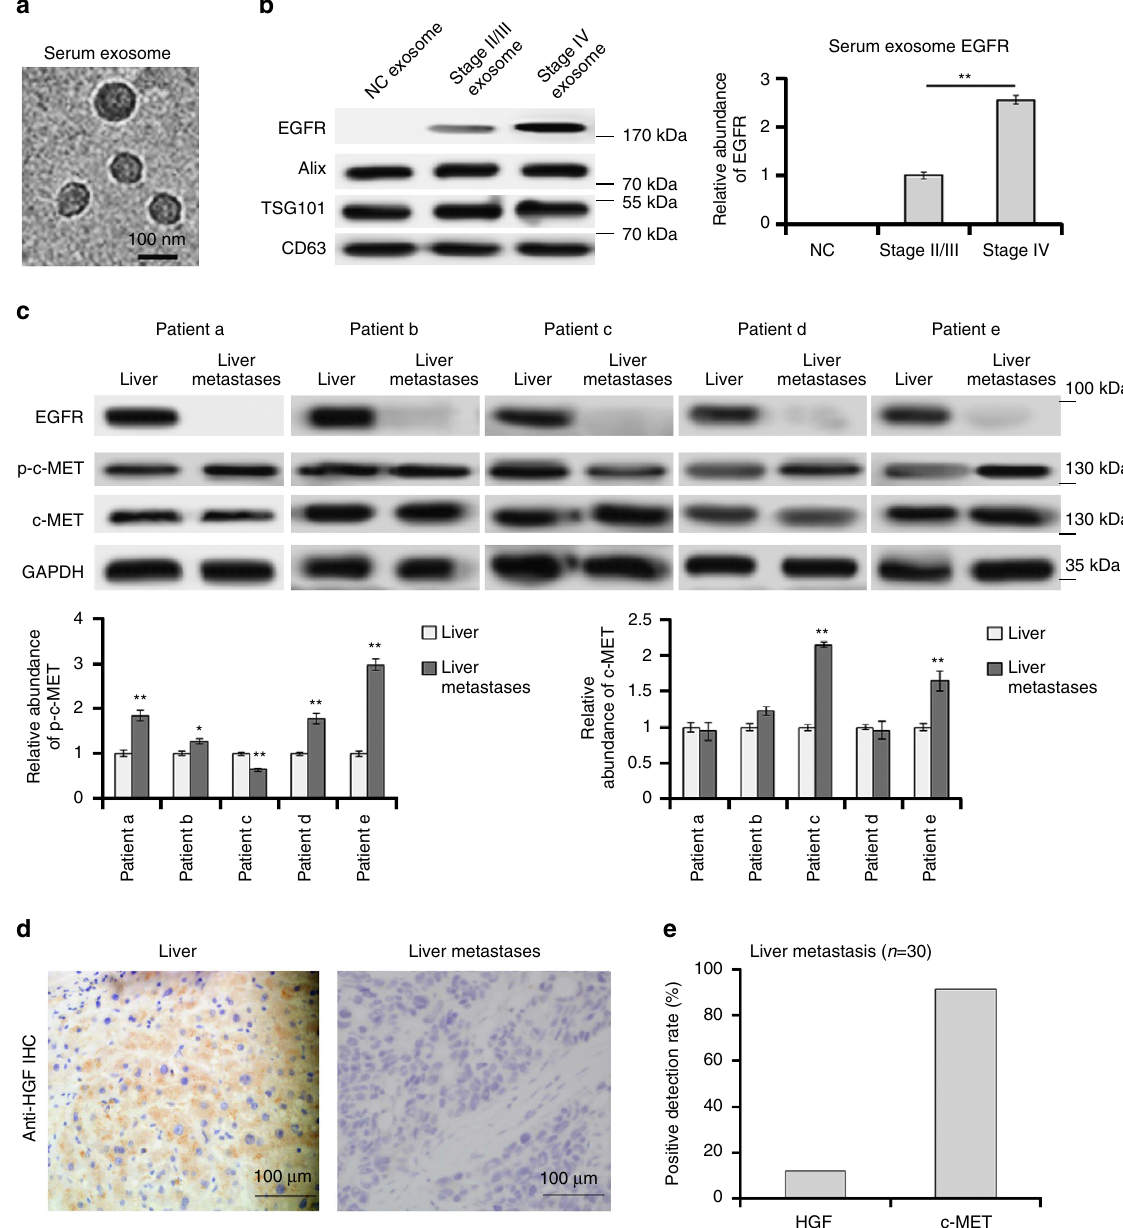
Figure 1 | Clinical analysis of sr-exosome EGFR and HGF-cMET in GC. ( a ) Electron microscope scanning of exosomes isolated from human serum. ( b ) Sr-exosome EGFR is related to the progression of GC. Exosomes were isolated from serum of healthy donors (NC), stage II/III GC patients and stage IV GC patients, respectively ( n ¼ 20); Alix, TSG101 and CD63 were used as the internal control of exosomes. ( c ) The expression of HGF, c-METand p-c-MET in para-carcinoma tissue (liver) and GC liver metastases ( n ¼ 5). ( d ) Immunohistochemistry (IHC) analysis of HGF in GC liver metastasis. ( e ) Positive ratio of HGF and its receptor c-MET in GC liver metastases ( n ¼ 30). The data represent the mean ± s.e.m. * P o 0.05, ** P o 0.01 (Student’s t